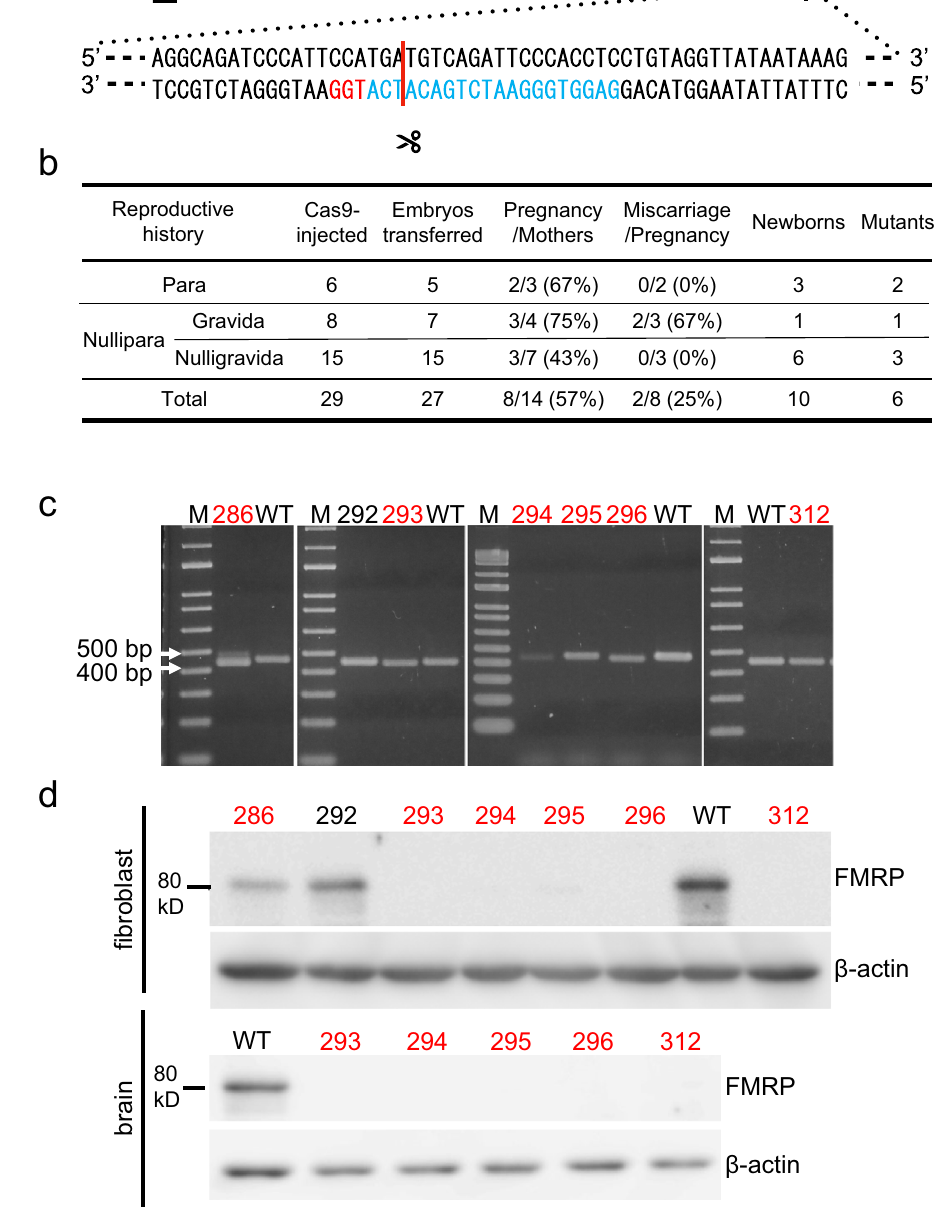
Figure 4. Generation of FMR1 mutant marmosets. ( a ) A schematic diagram of the FMR1 locus is shown. A white square indicates a non-coding exon, and black squares indicate coding exons. The positions of double- strand break by Cas9 (red bar) were designed in a coding exon. A protospacer adjacent motif (PAM) and 20 nucleotides adjacent to the PAM are shown in red and blue. Genotyping primers (arrows) produce a 411bp DNA fragment. ( b ) The efficiency of CRISPR/Cas9 to generate mutant marmosets. The injection was performed into the cytoplasm of 29 pronuclear stage embryos, and 6 of the 10 newborns carried FMR1 mutations. Both parous and nulliparous females efficiently produced mutant marmosets. ( c ) PCR products of newborns (#286, #292, #293, #294, #295, #296, and #312) were separated on 2% agarose gels. Red numbers indicate mutants. As a control, PCR products (411 bp) using genomic DNA extracted from hair follicles of wild-type (WT) marmosets were used. ( d ) Western blot analysis of FMRP and β-actin. Proteins extracted from fibroblasts and whole brains were separated on 8% polyacrylamide gels. All lanes contain 10 μg of protein. The blots cropped from different parts of a same gel were separately shown with a white